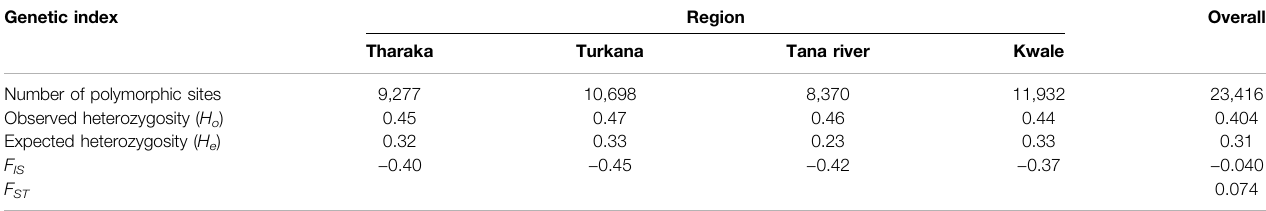
TABLE 2 | Mean values of genetic diversity indices determined for Hyphaene compressa accessions in the sampled populations. Genetic index